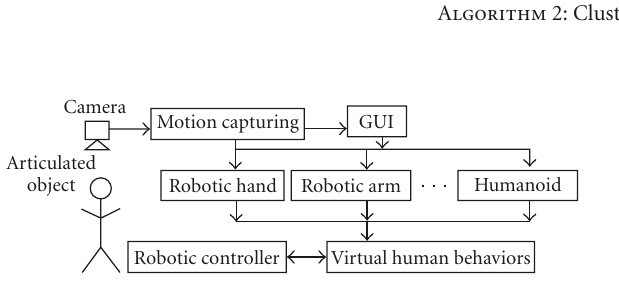
Algorithm 2: Cluster head operations.